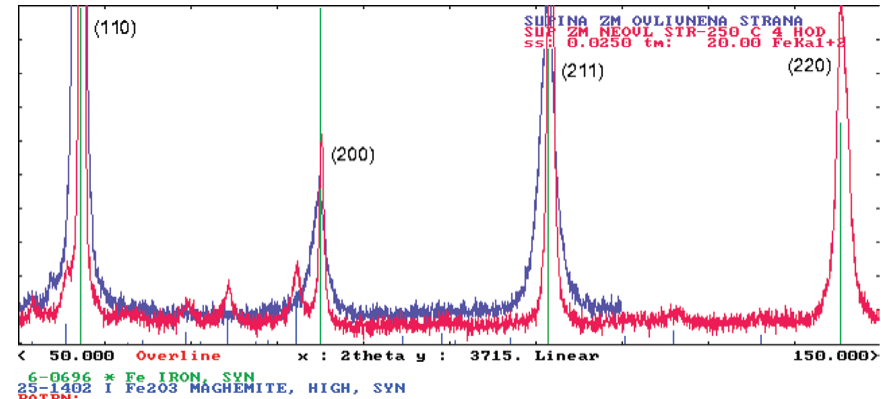
Fig. 4. X-ray diffraction plot made on the non-influenced side of the rail-chip after the next annealing 250°C / 4 hrs (including comparison with the influenced